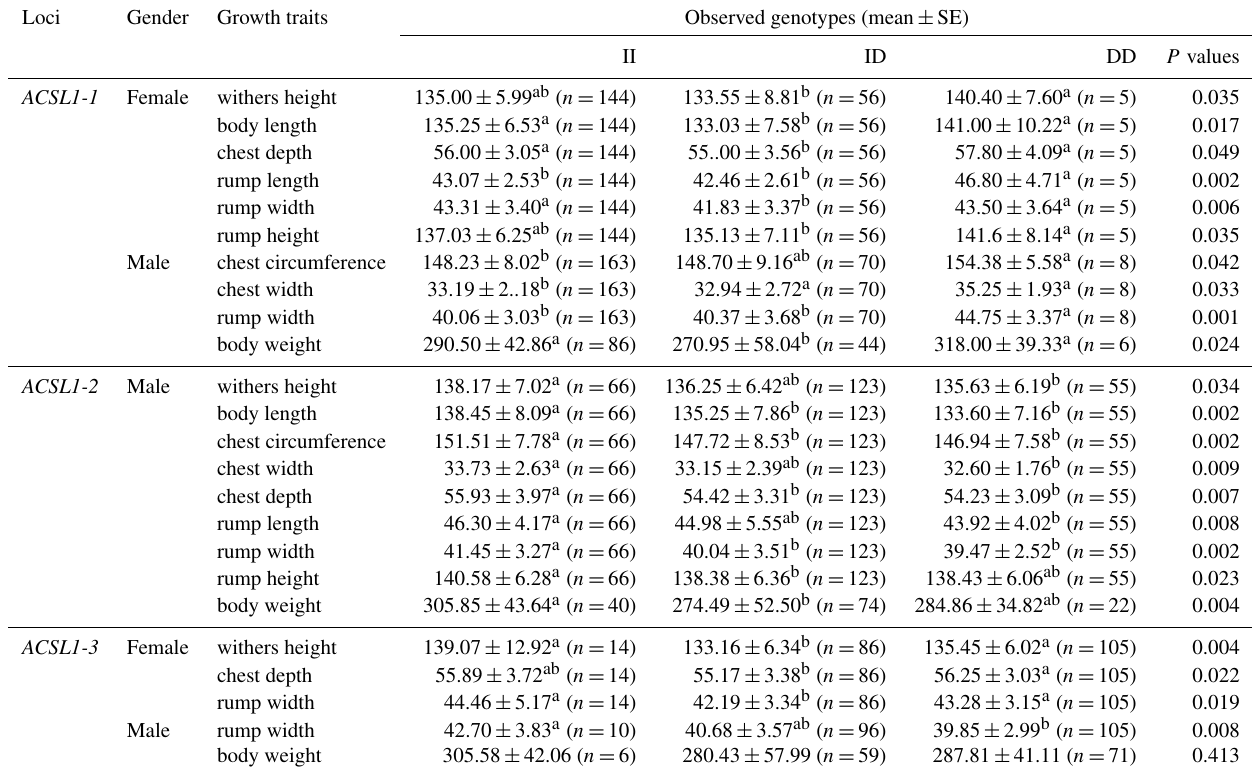
Table 4. Association between ACSL1 gene mutation loci and growth traits in Dezhou donkeys of different genders. Loci Gender Growth